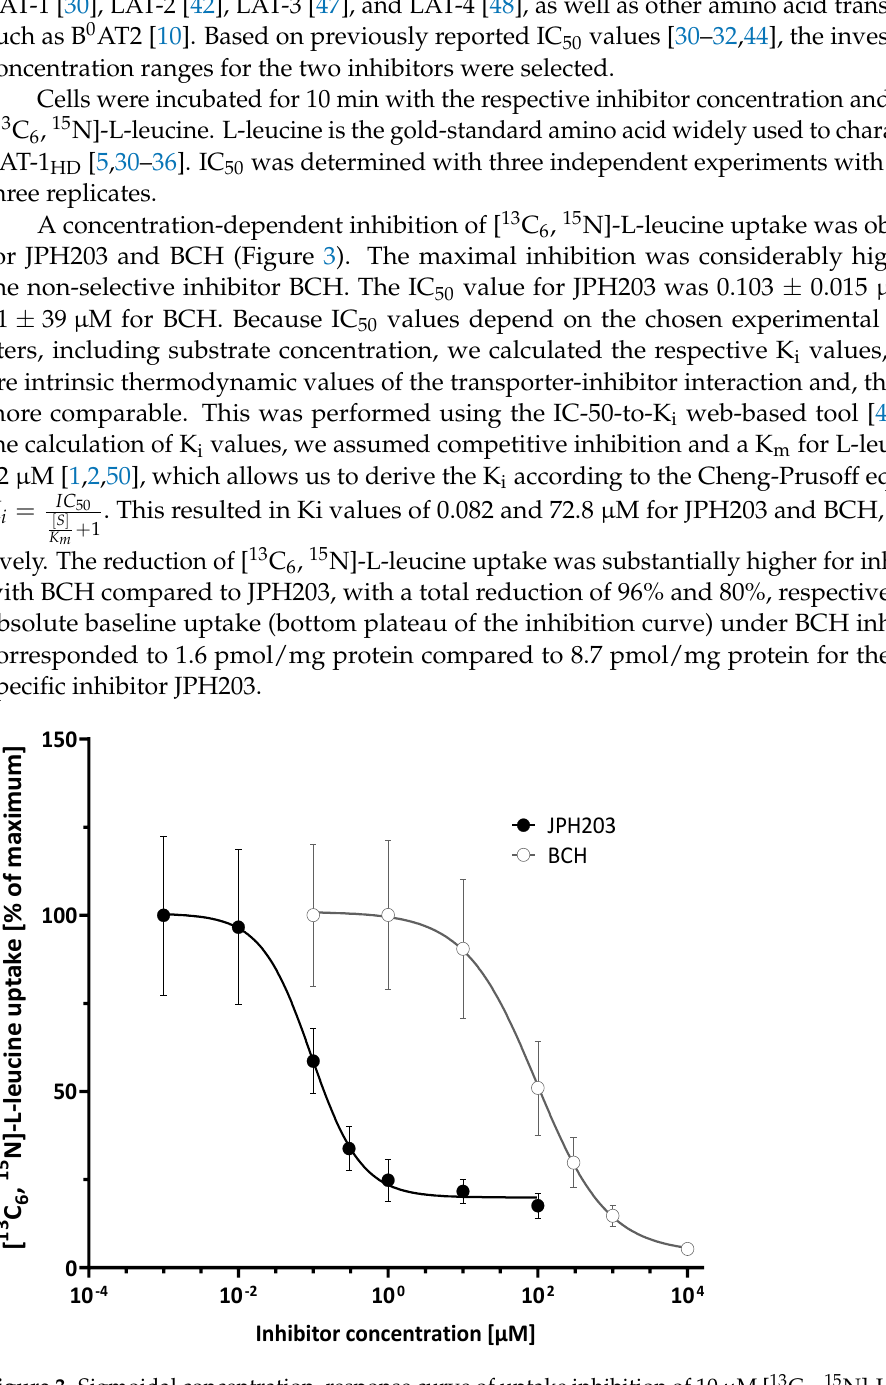
Figure 3. Sigmoidal concentration–response curve of uptake inhibition of 10 µ M [ 13 C 6 , 15 N]-L-leucine by JPH203 and BCH in hCMEC/D3 cells. Data are depicted as mean ± SD from three independent experiments with at least three replicates.